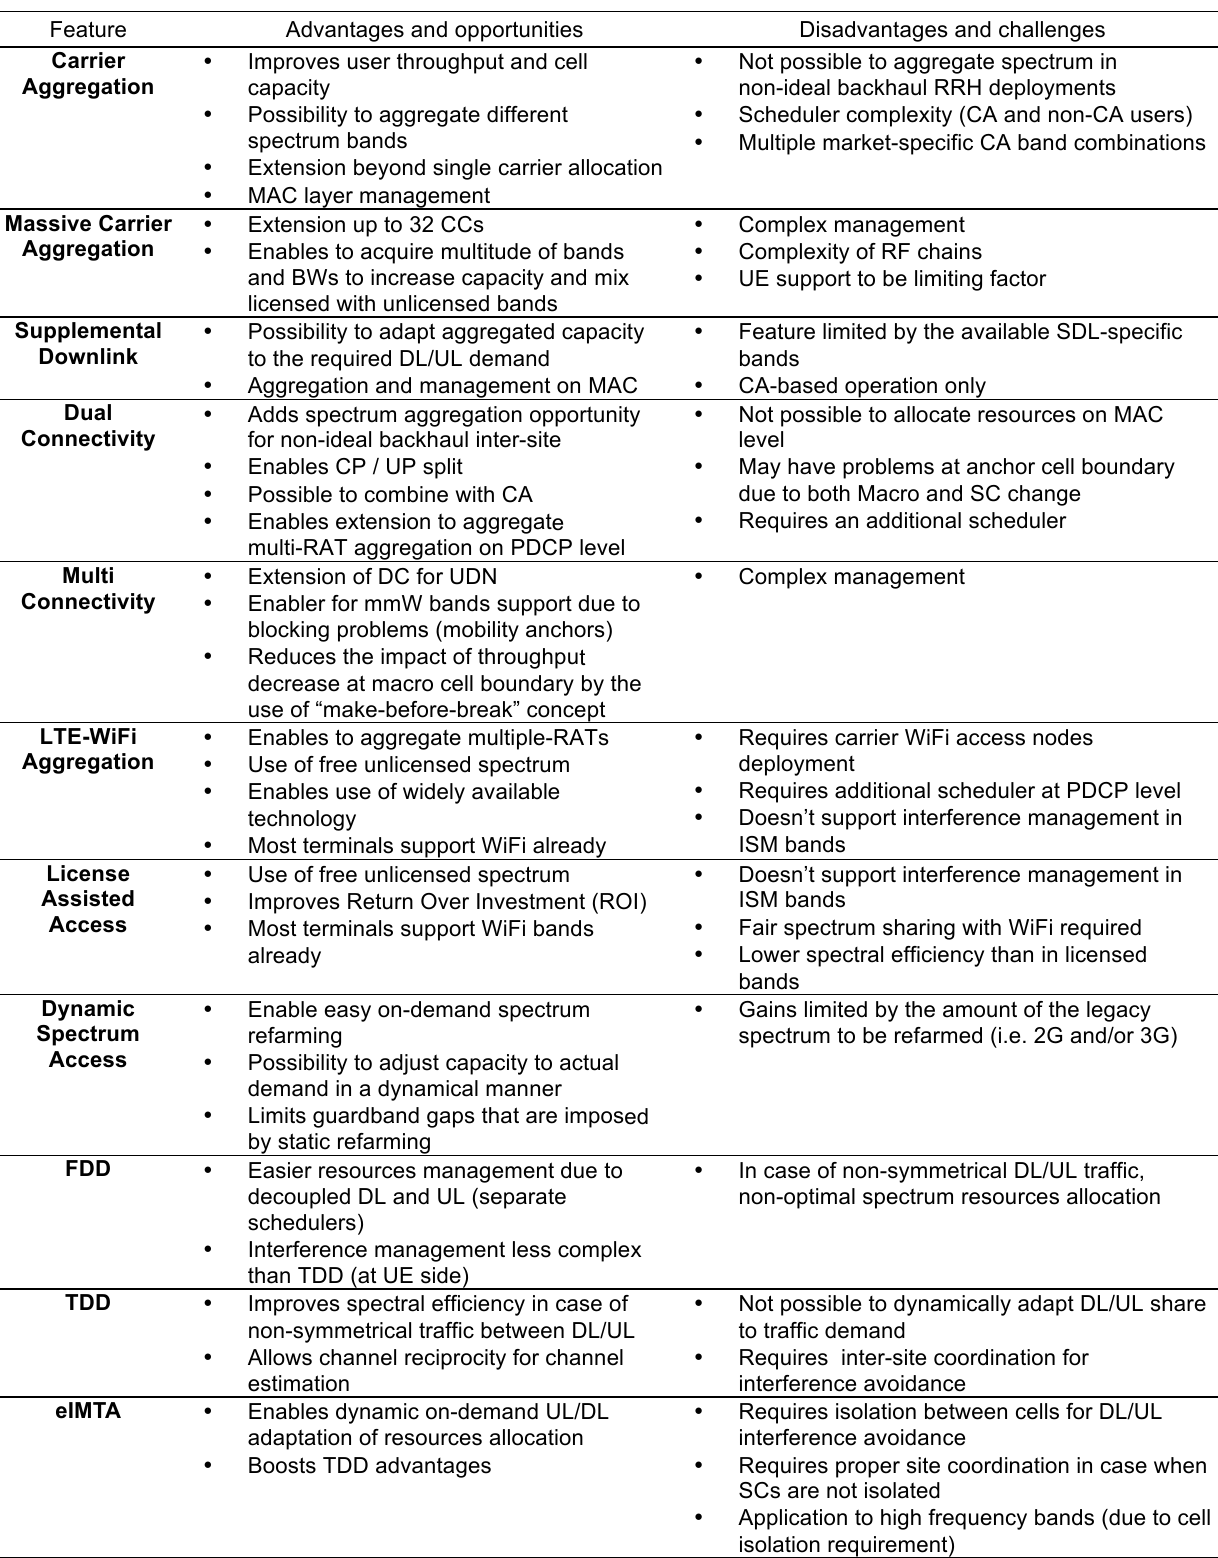
Table 4. Advantages and challenges of the Spectrum Toolbox